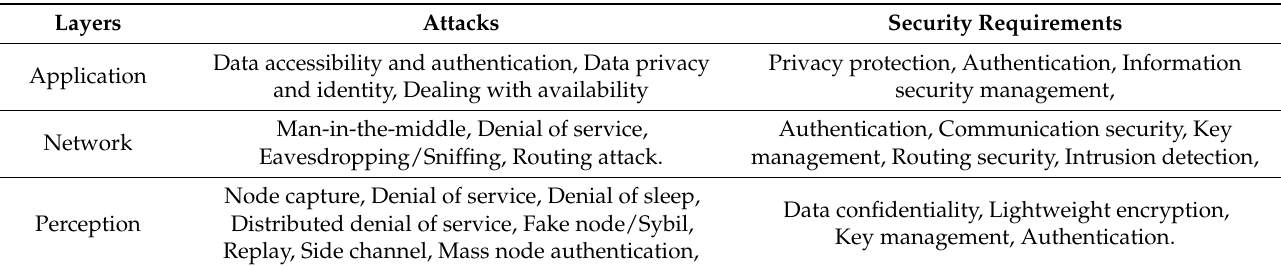
Table 2. IoT architecture, attacks, and security